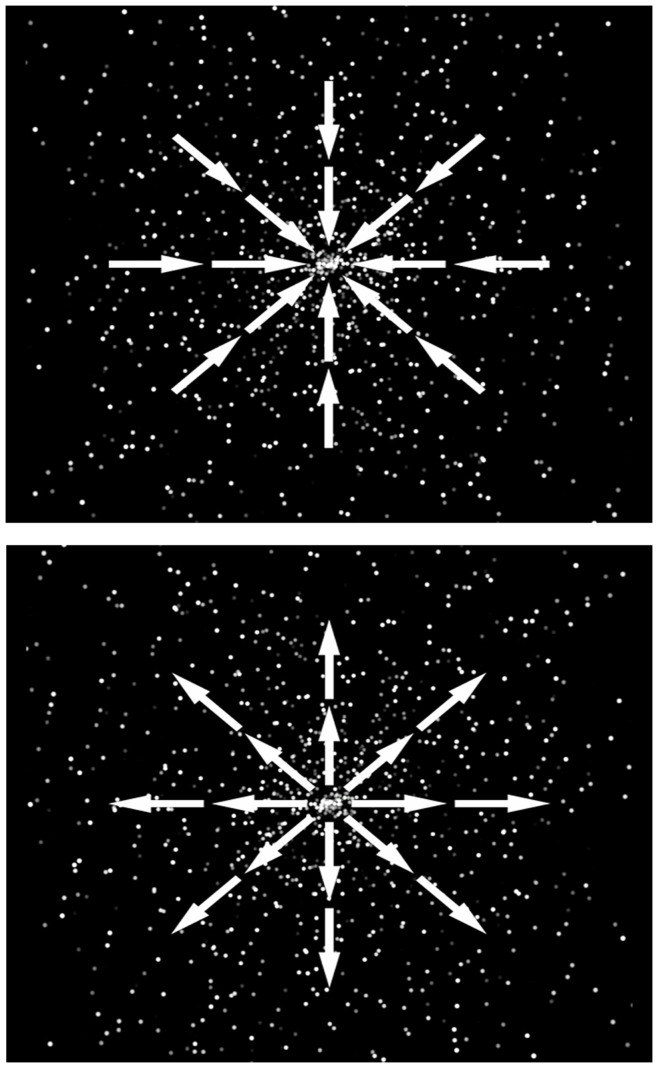
Vection Displays.Illustrations of the direction of optical flow specified by the star-field displays in Experiment 2. The top panel shows centripetal flow specifying backwards vection (i.e., past trials) while the bottom panel shows centrifugal flow specifying forwards vection (i.e., future trials).